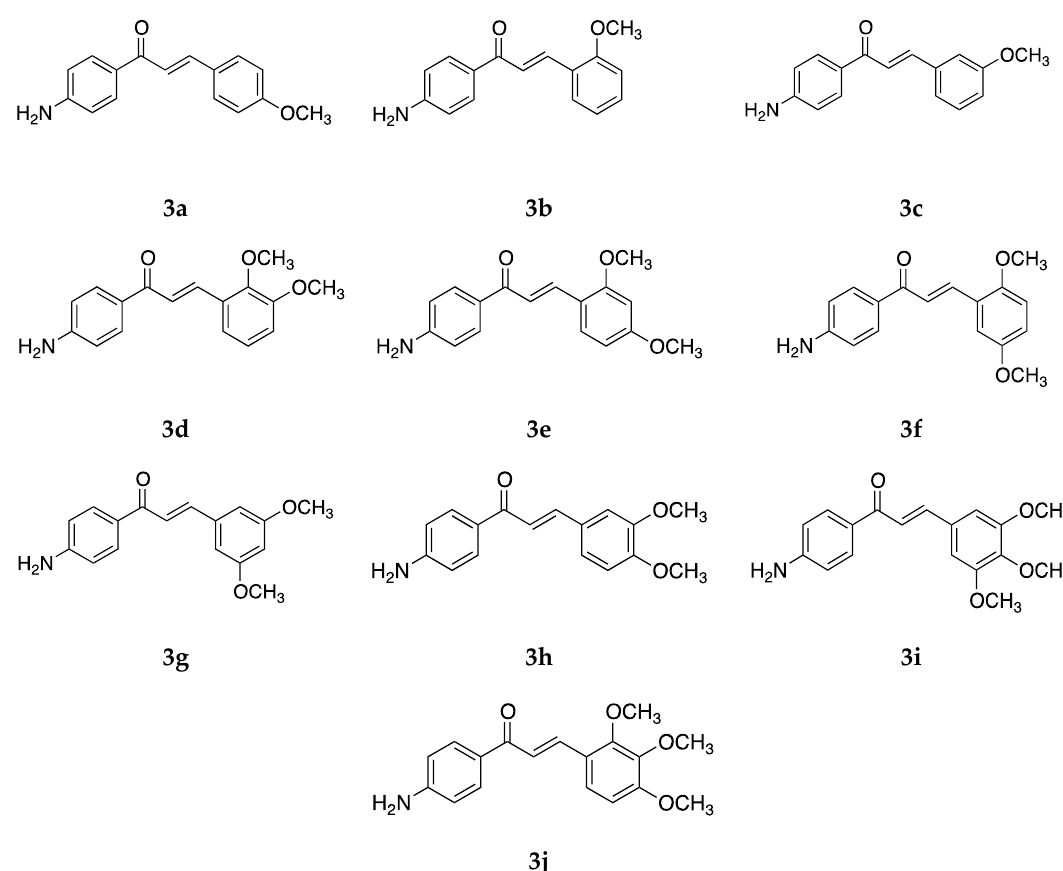
Figure 4. Chemical structure of 4-aminochalcone derivatives with methylation on ring B.